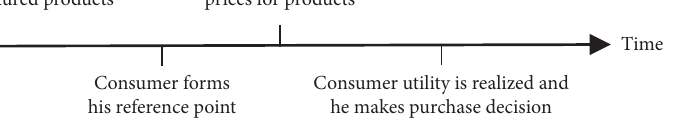
Figure 1: The timing of the game.